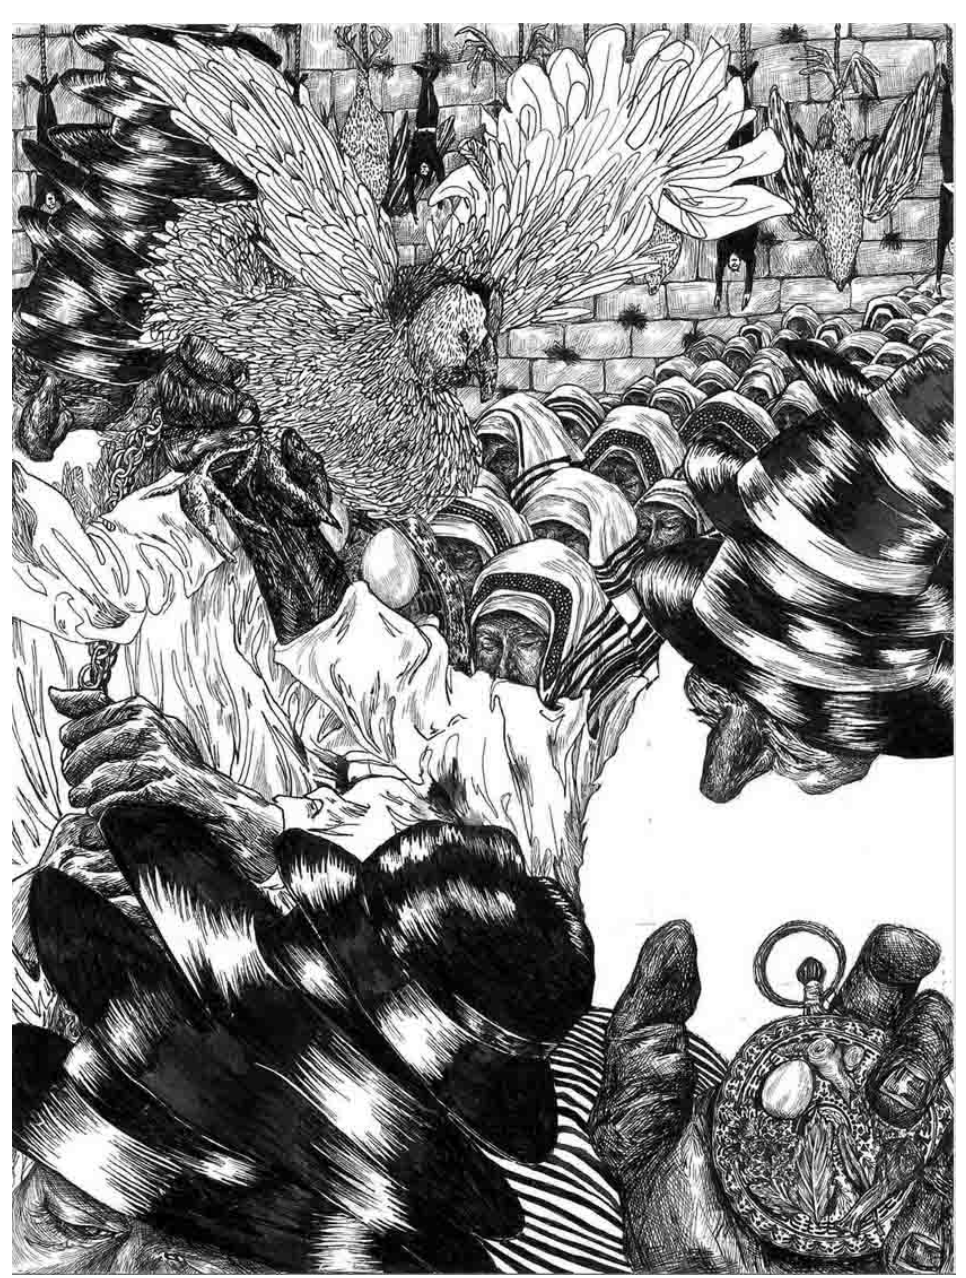
Rosabel Rosalind Kurth-Sofer, Exodus II , 2018. Pen and ink on paper. 9x11